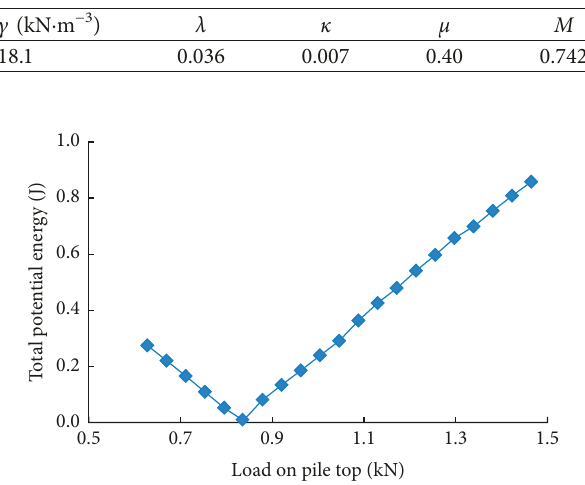
Figure 5: Picture of the pile group with load. Table 1: Physical mechanical index of soils.